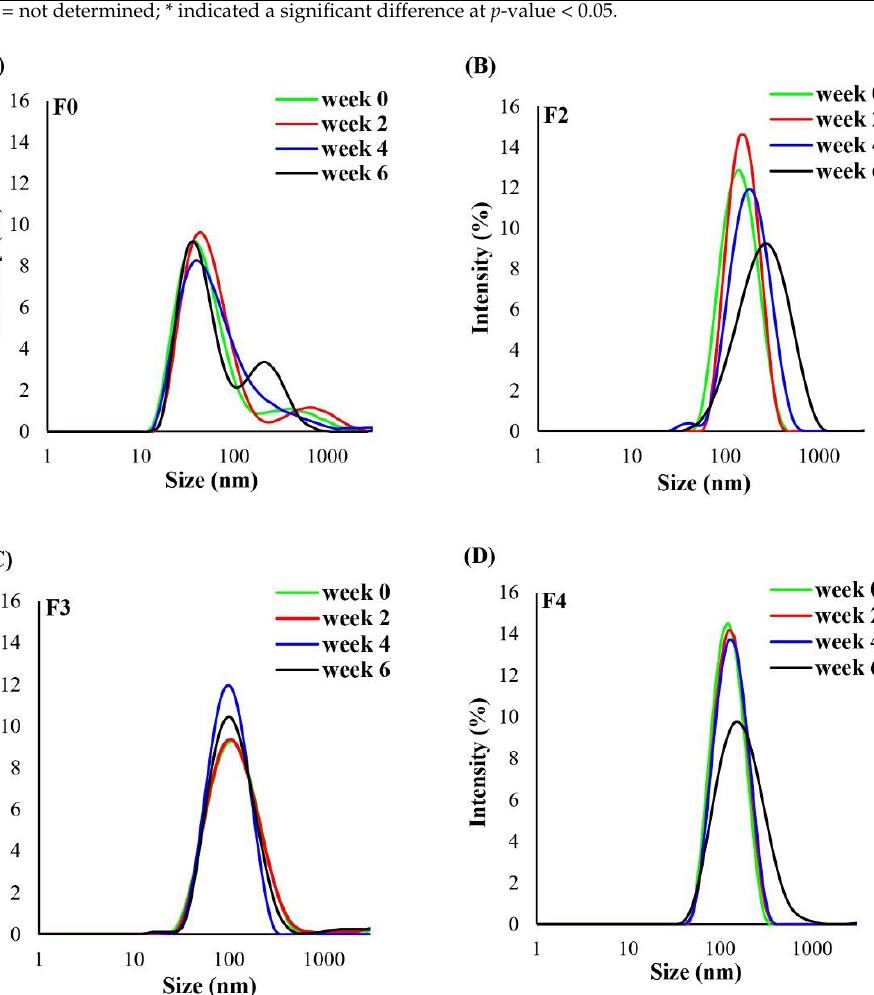
The zeta potential of F0, F2, F3, F4, and F5 was −24 . 40 ± 0 . 26, −16 . 57 ± 0 . 06, −30 . 93 ± the nanoparticles has been demonstrated to prevent the growth of larger particles because the increasing electrostatic repulsion overcomes van der Waals interaction . It also results in a decrease in the hydrodynamic size, and then the agglomeration is inhibited [ 32 ]. F0 and F3 had high surface charge based on the zeta potential, and therefore they showed no agglomeration of particles and had good size dispersibility . In contrast, F2, F4, and F5 had lower zeta potential, and then they tended to form larger flocs with large variations in particle size . These supported our result that higher size deviations based on TEM meas- urement and broader UV spectra were found in such formulations ( F2, F4, and F5 ).